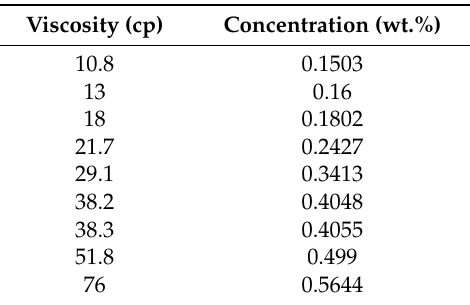
Table 2. Polymer viscosity and polymer concentration parameters.